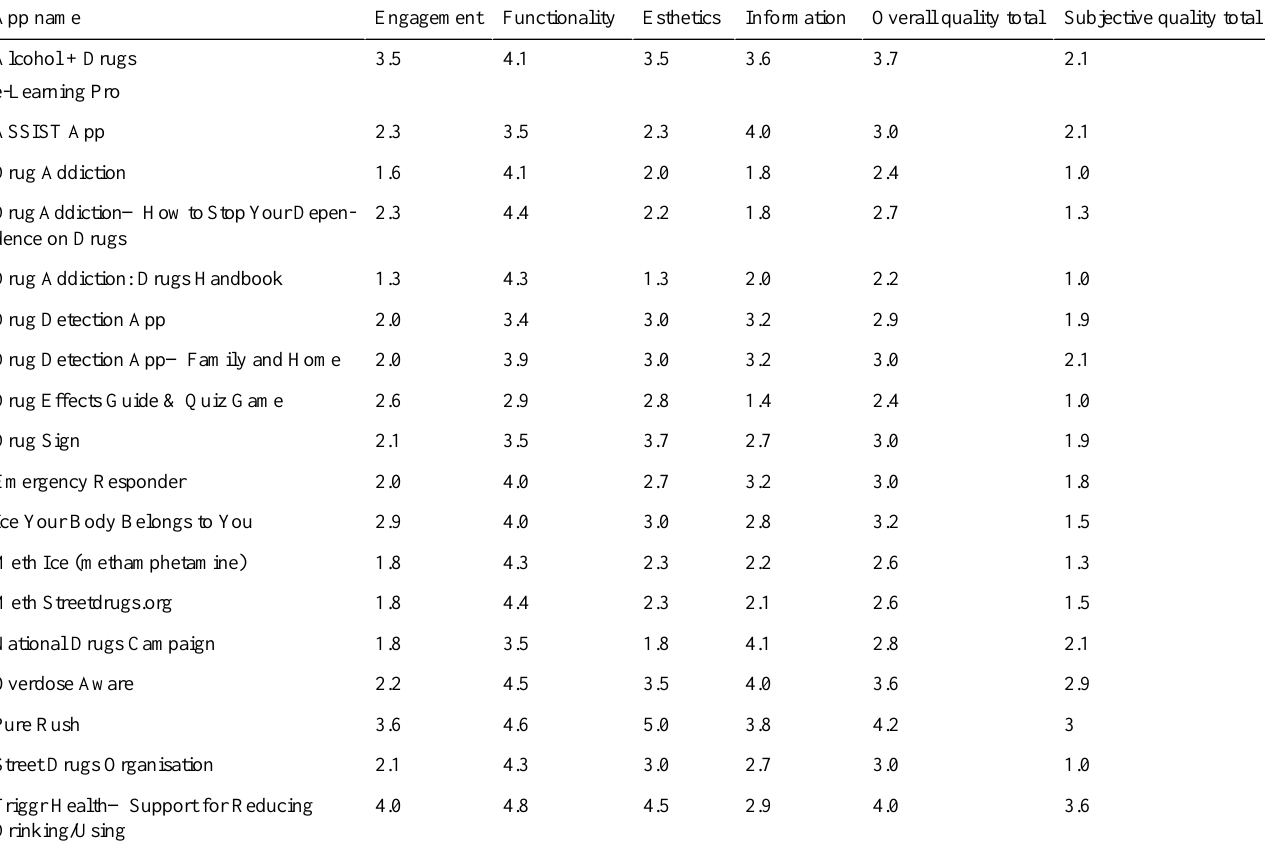
Table 3. Mobile Application Rating Scale ratings.